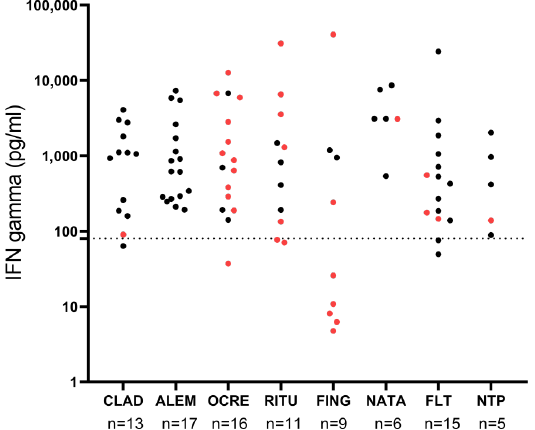
Figure 2. Concordance between cellular and humoral responses. Black dots indicate patients who developed a protective humoral response. Red dots indicate patients who did not develop a protec- tive humoral response. Dotted line marks IFN-γ levels of 80 pg/mL that were considered positive. ALEM: alemtuzumab; CLAD: cladribine; FING: fingolimod; FLT: first-line therapies; NATA: natali- zumab; NTP: non-treated patients; OCRE: ocrelizumab; RITU: rituximab.